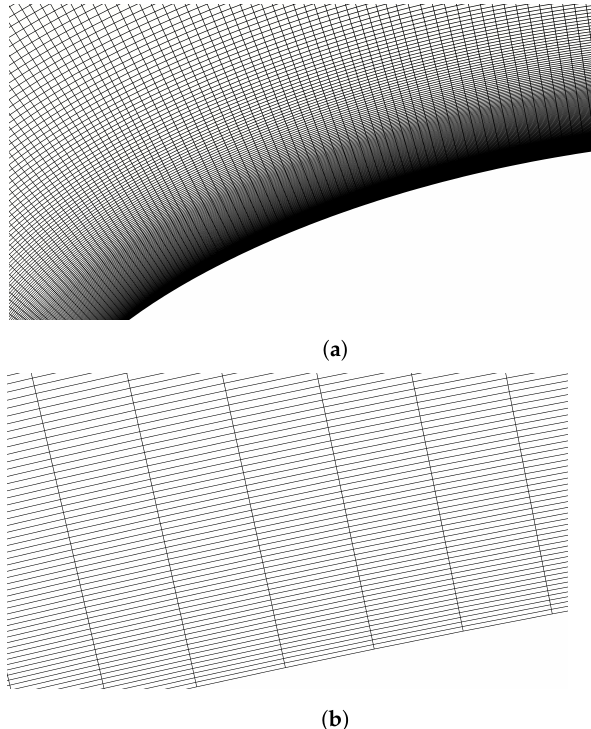
Figure 4. Detailed view of the near-wall region of the mesh. ( a ) Close up view of the structured sub-mesh. ( b ) Close up view of the LE region structured